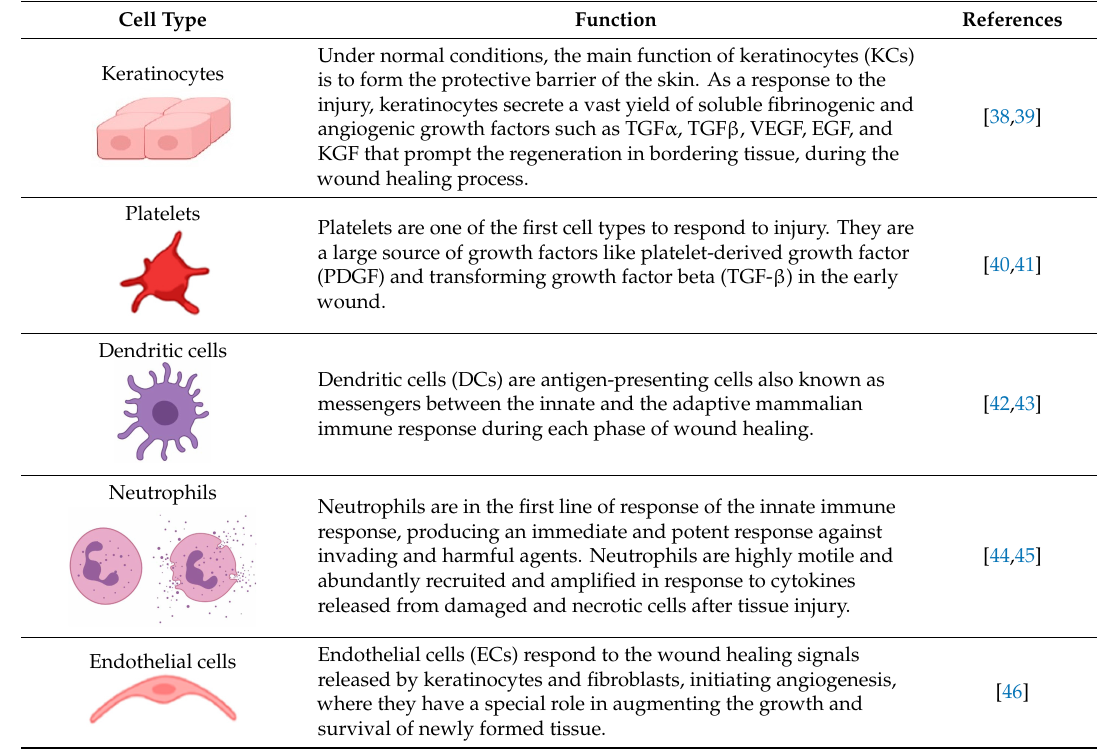
Table 1. Roles of the di ff erent cells and structures in the skin during wound healing. Table 1. Roles of the different cells and structures in the skin during wound healing. Table 1. Roles of the different cells and structures in the skin during wound healing. Table 1. Roles of the different cells and structures in the skin during wound